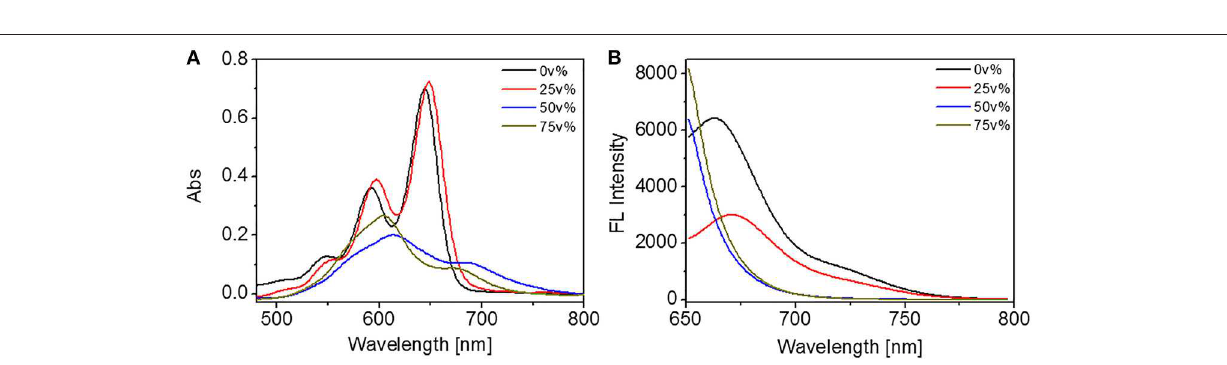
Frontiers in Chemistry |